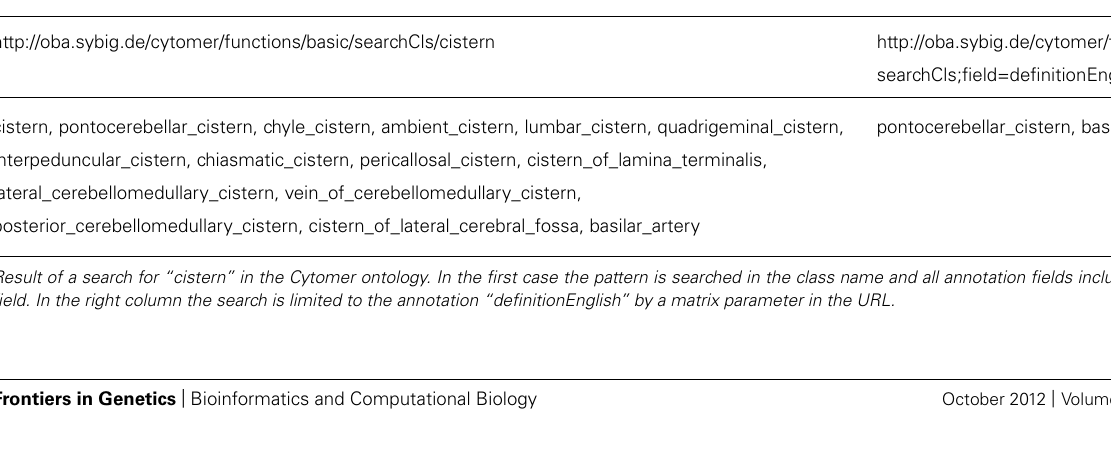
Table 1 | Generic search with a limitation to an annotation